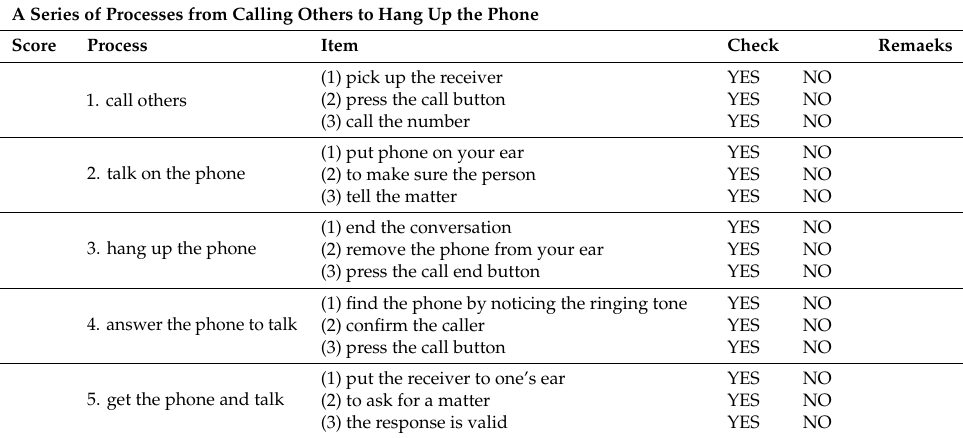
Table 2. Example of PADA-D (ability to use the telephone).